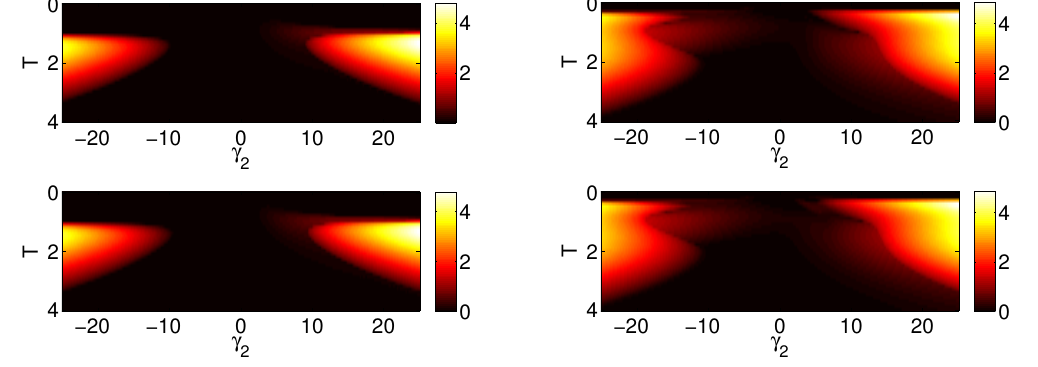
and T while the value of 2 and T while 2 = − 1 , γ = 5 in the 1 3